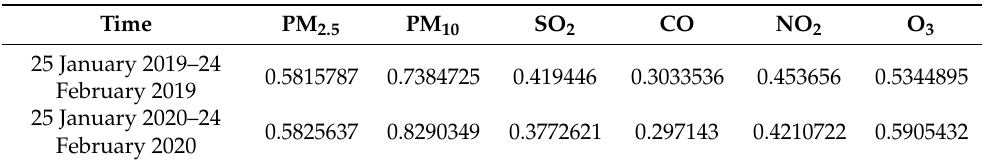
Table 4. The gray relational degree between pollutants and AQI between 25 January 2019–24 February